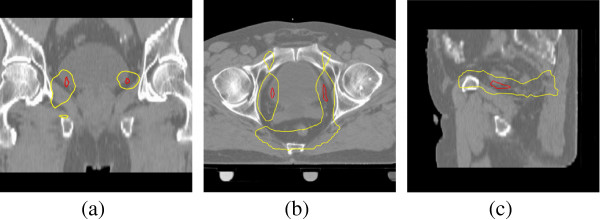
The region (marked in red) with significant dose difference (adjusted p-value < 0.05) from the permutation test in the prostate study, together with the region (marked in yellow) with p-value < 0.05 in a voxel-by-voxel based t test. (a) coronal view; (b) axial view; (c) sagittal view.